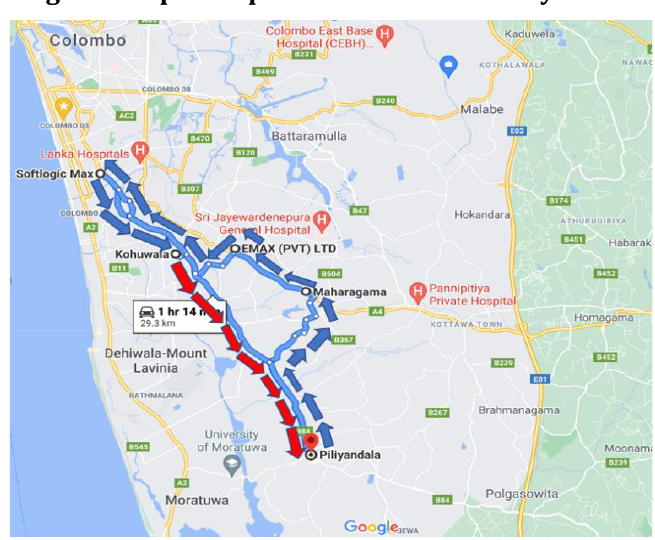
Figure 2: Optimal path of Cluster 01 – Piliyandala